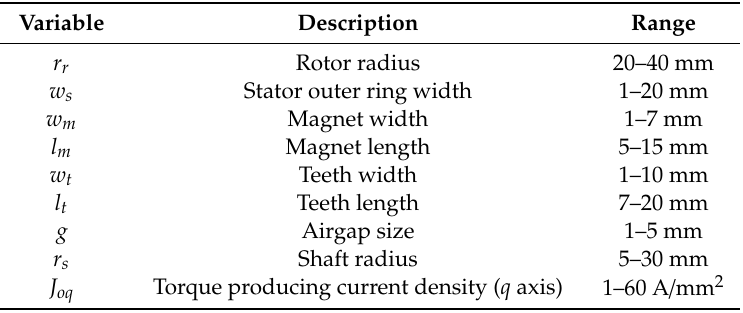
Table 6. Optimization decision variables.